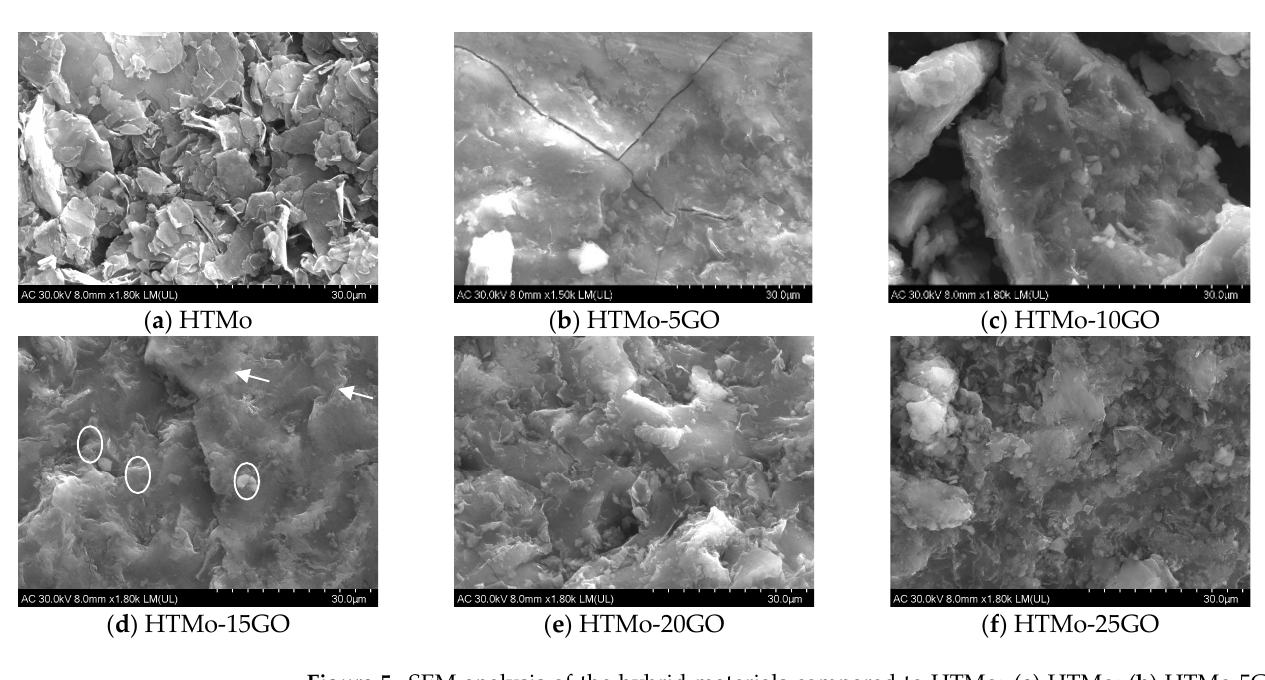
Figure 5. S Е M analysis of th е hybrid mat е rials compared to HTMo: ( a ) HTMo; ( b ) HTMo-5GO; ( c ) Figure 5. SEM analysis of the hybrid materials compared to HTMo: ( a ) HTMo; ( b ) HTMo-5GO;